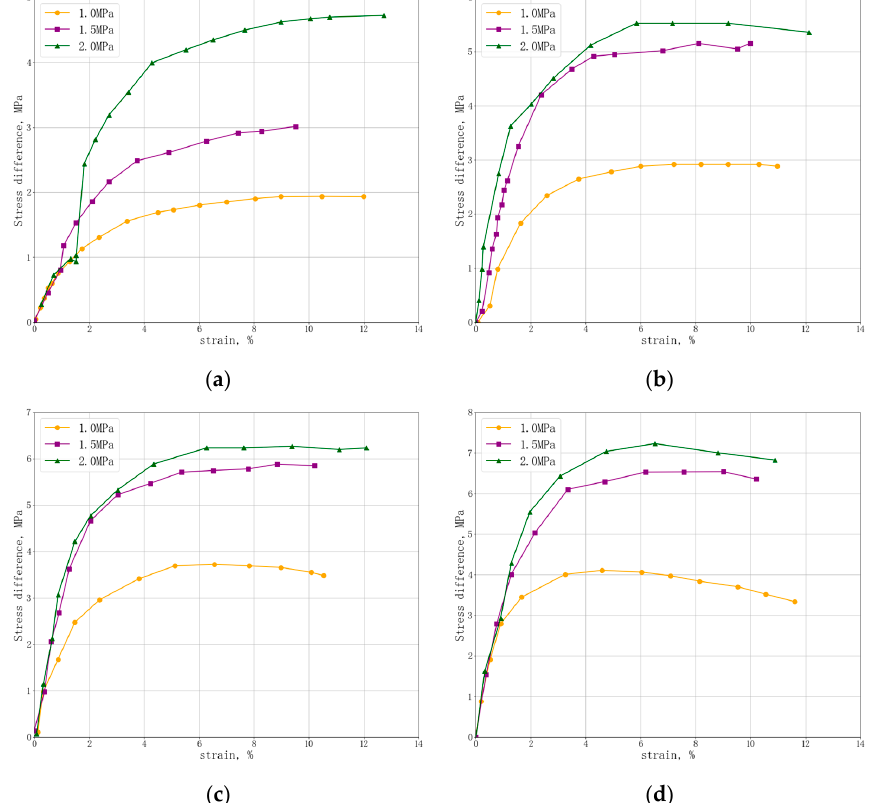
Figure 5. Stress–strain curves of different hydrate saturations under different net confining pressures. ( a ) Stress–strain curves at 0% saturation. ( b ) Stress–strain curves at 15% saturation. ( c ) Stress–strain curves of 25% saturation. ( d ) Stress–strain curves of 35% saturation. (2) Angle of Internal Friction and Mohr’s Circle Figure 6 shows the Mohr circles calculated from triaxial shear test data. According to the results of the triaxial shear test, the self-made MATLAB program drew the Mohr’s circle and solved the internal friction angle and cohesion.